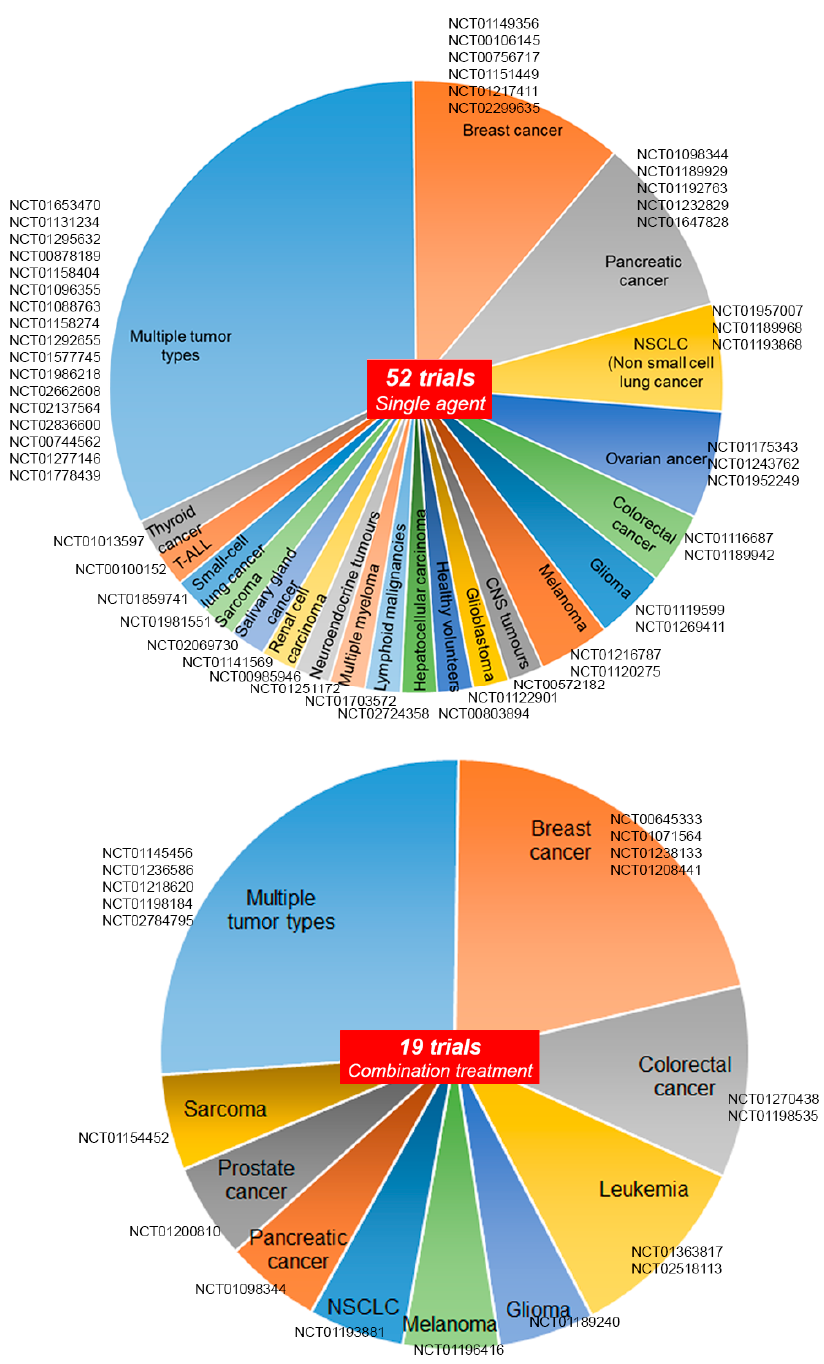
Figure 4. Clinical trials (named by the NCT ClinicalTrials.gov identifier) for the treatment of the indicated tumor types based on the use of Notch inhibitors, either as a single agents (upper panel) or in combination with other drugs (lower panel).